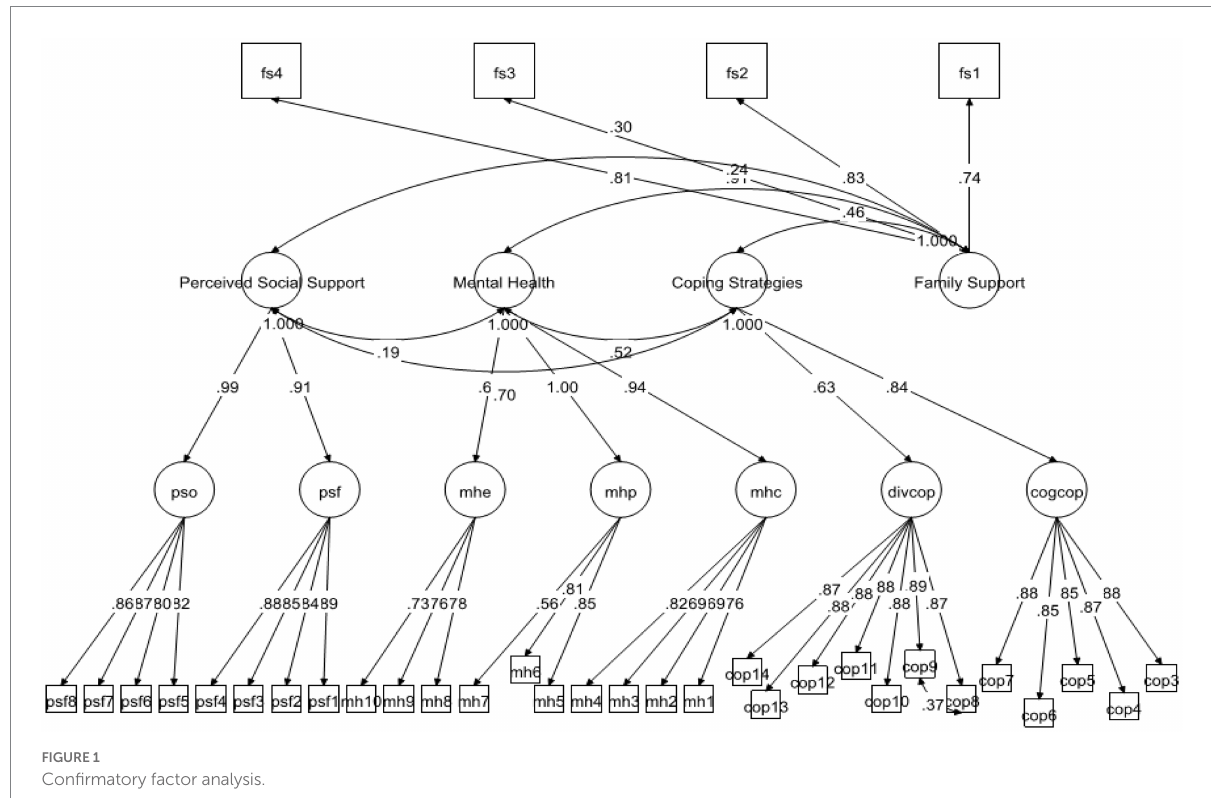
FIGURE 1 Confirmatory factor